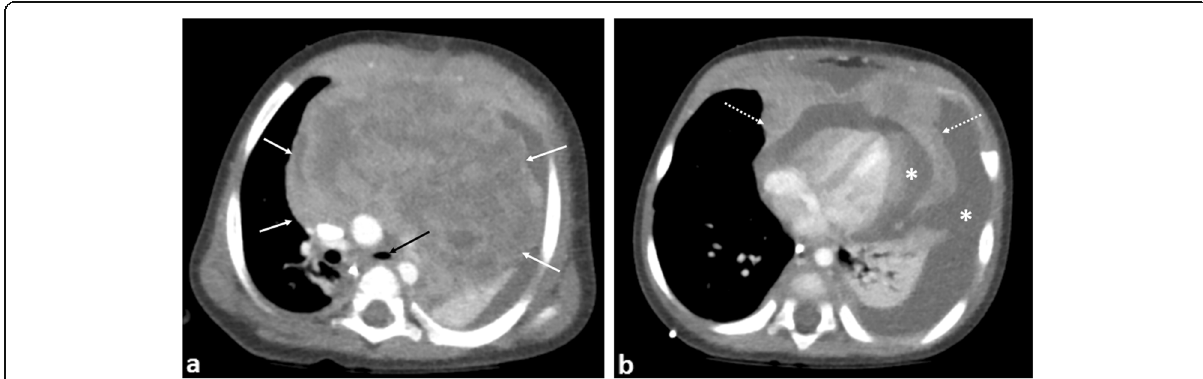
Fig. 10 An 8-month-old boy with T-cell lymphoblastic lymphoma. a Contrast-enhanced axial CT image of the superior mediastinum and ( b ) at the level of the cardiac ventricles demonstrate a large heterogeneously enhancing anterior mediastinal mass (white arrows) with pericardial invasion (dashed arrows). There is narrowing of the left main bronchus (black arrow), left lung collapse and a large pericardial and left pleural effusion (asterisks)